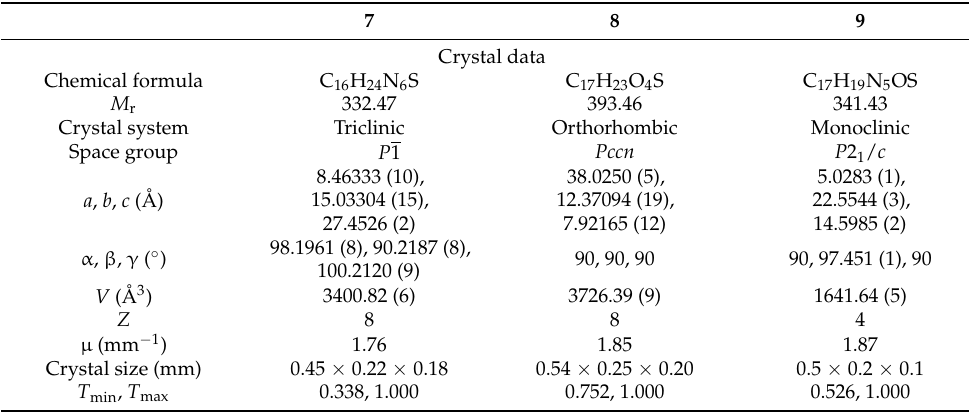
Table 5. Crystal data, data collection, and refinement details of compounds 7 – 9